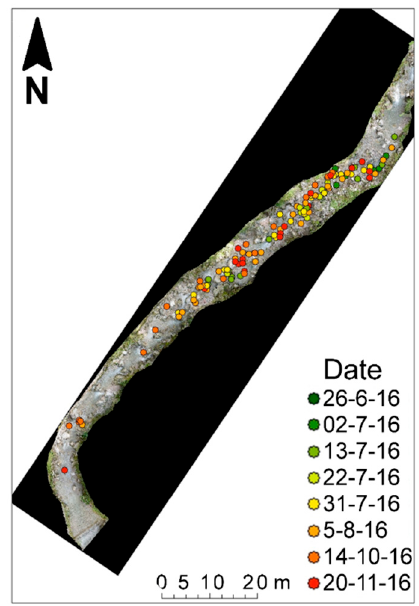
Figure 6. Positions of tracers in 2016 events for reach 6, where each color represent a date. Notice how the pebbles move downstream in time and remain in the thalweg of the river.